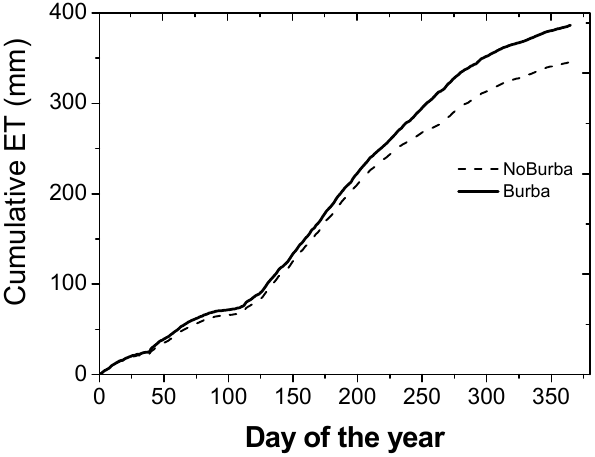
Fig. 8b. Cumulative evapotranspiration (mm) throughout the year 2007 (dashed line without and black line with the Burba correction applied).